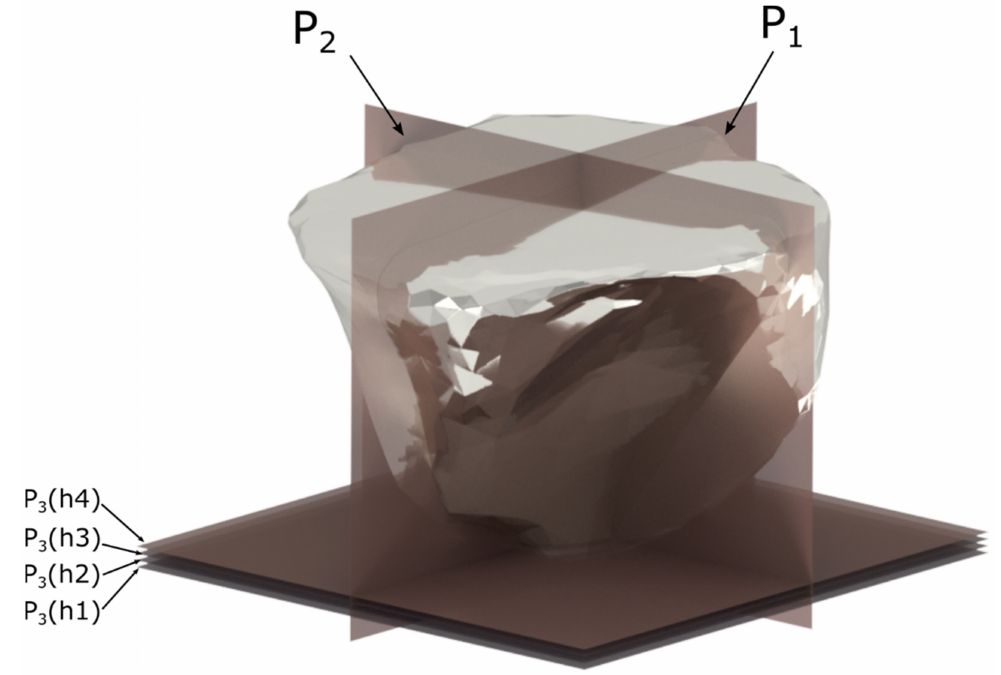
Figure 4. Geometrical features of the abrasive